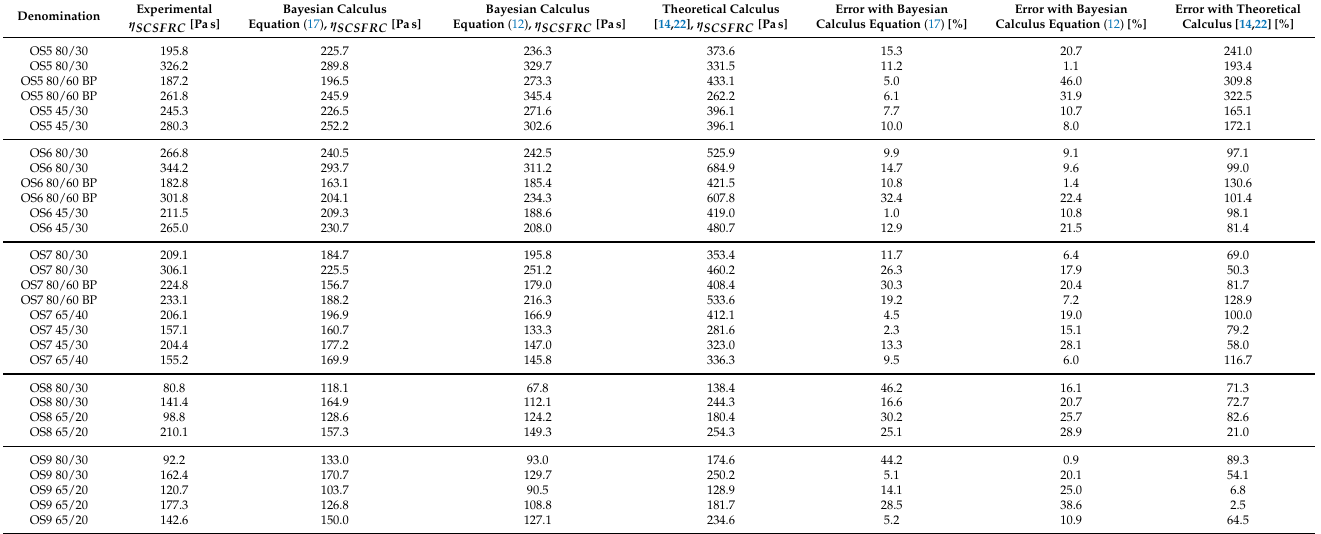
Table 6. Experimental values, models’ values, and estimated error for SCSFRC (Grünewald [32]): Series